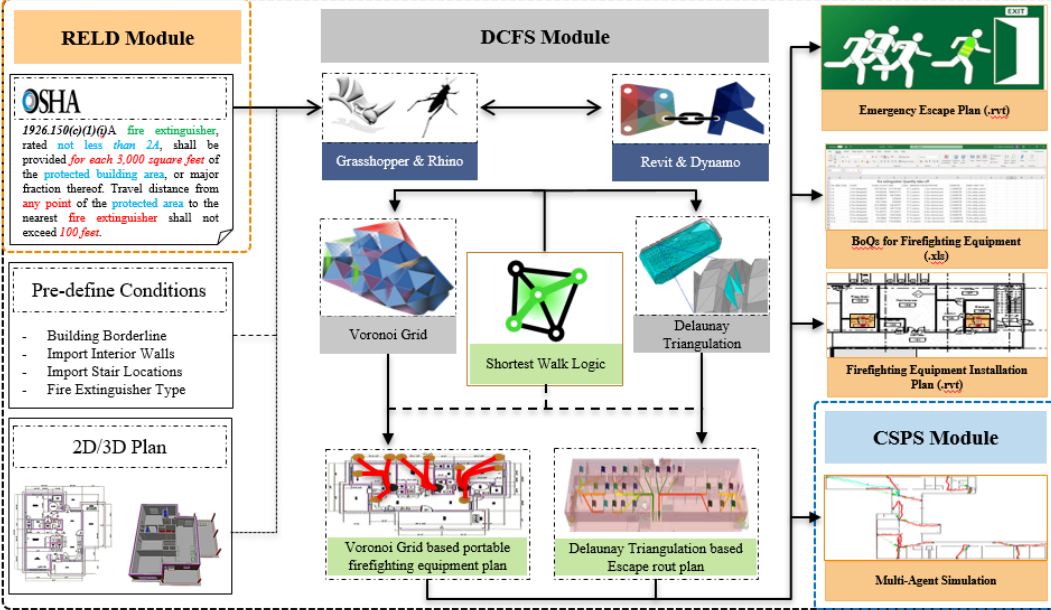
Figure 2. System architecture for Con-fire safety planning approach.